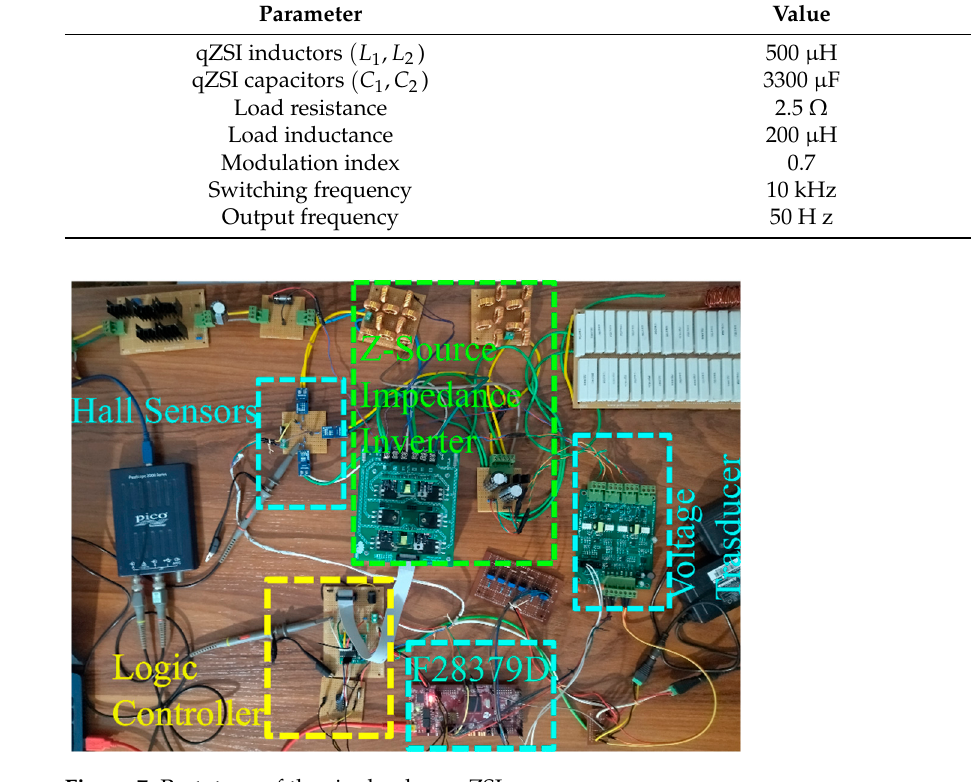
Figure 7. Prototype of the single-phase qZSI.